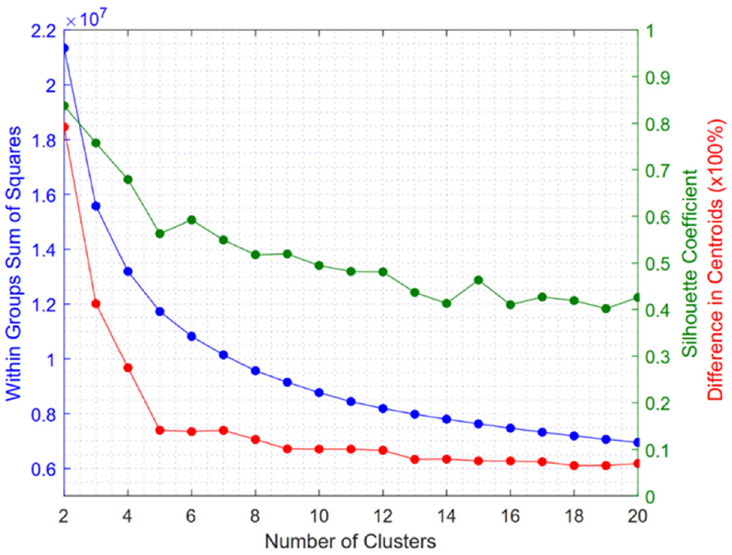
Figure 4. Determination of appropriate number of clusters.